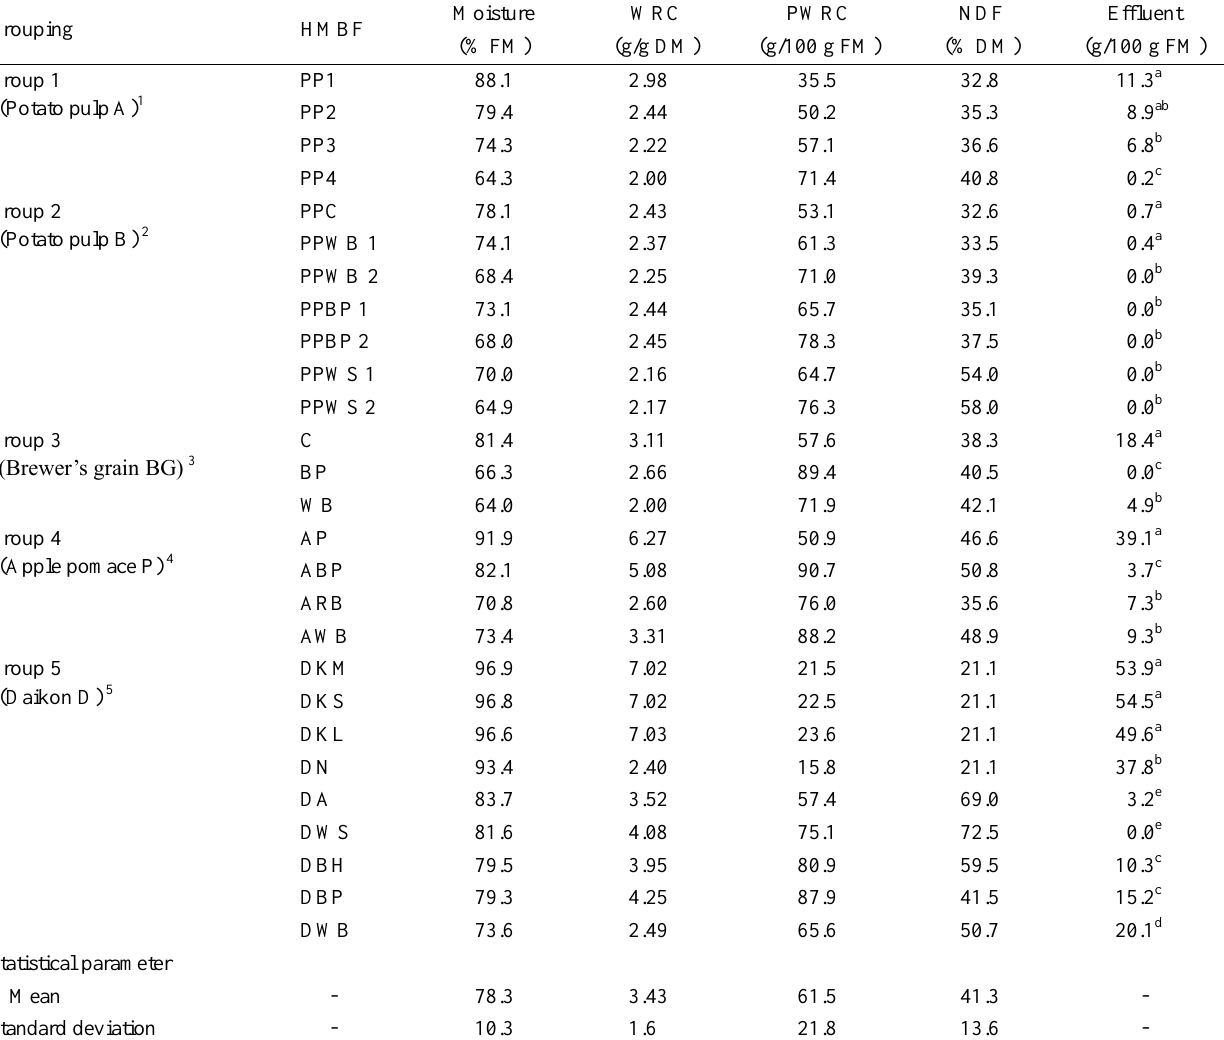
Table 1. Chemical parameters of some high moisture by-product feedstuffs (HMBF) adjusted with or without absorbents and effluent outputs from their silages* Grouping HMBF